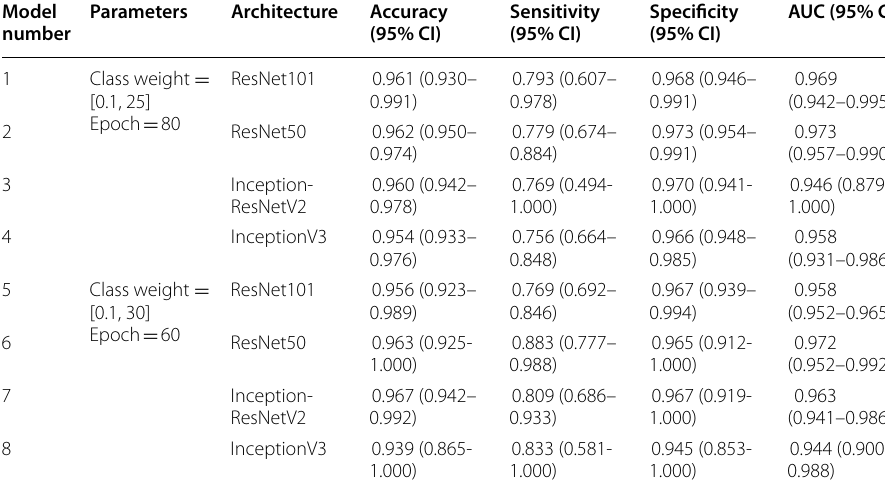
CI confidence interval, AUC area under curve